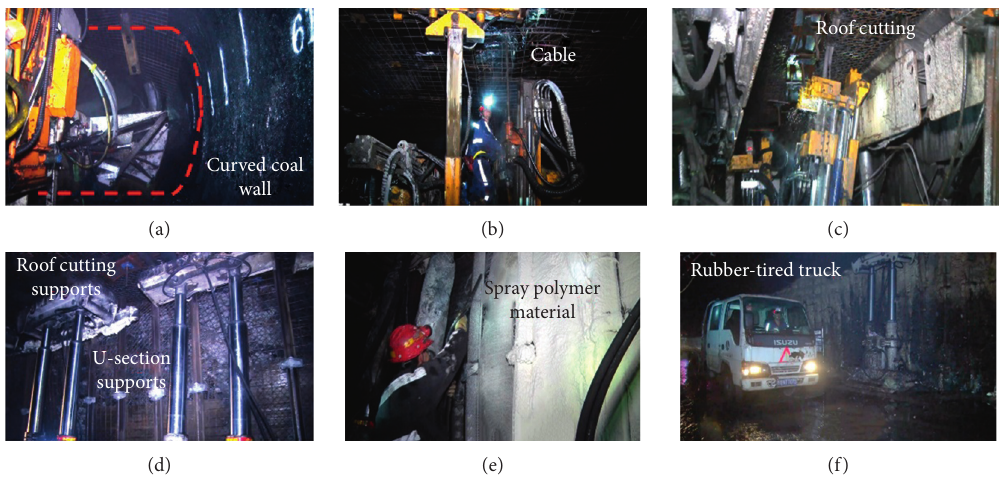
Figure 3: Technological process of this new method with roadside cutting: (a) cut out the roadway space; (b) support with the NPR cables; (c) the drilling process of the roof cutting drill; (d) the roof cutting supports were used as the temporary supports; (e) polymer sealing material was sprayed to close the gob promptly; (f) extralarge section roadway can be retained for the auxiliary